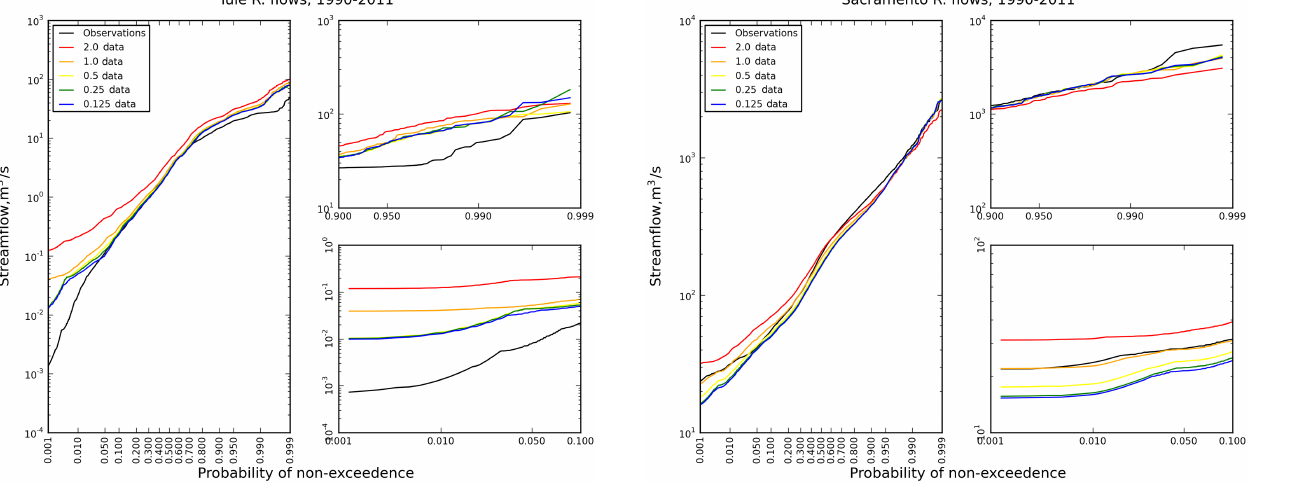
Figure 6. Cumulative distribution function for the daily streamflows at the Tule River gauge. The full CDF is in left panel, upper right panel expands the highest 10% of flows, and the lower right high- lights the 10% lowest flows.